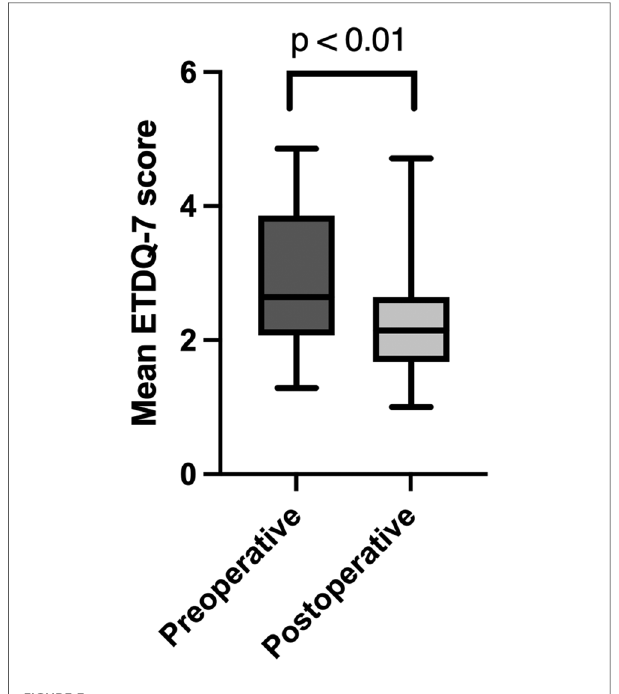
FIGURE 3 Mean overall ETDQ-7 score preoperatively and at a 3-month